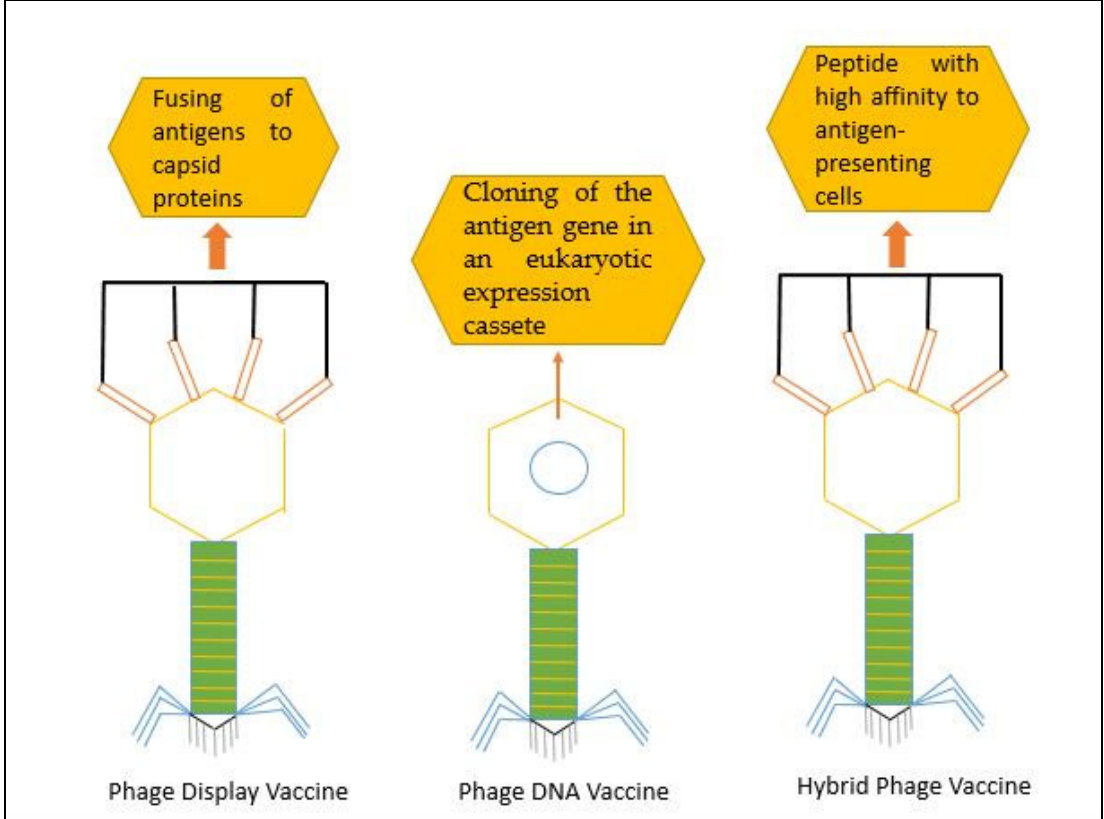
Figure 1. Basic representation of three different types of phage ‐ based vaccines; phage display vac ‐ cines, phage DNA vaccines, and hybrid phage vaccines.